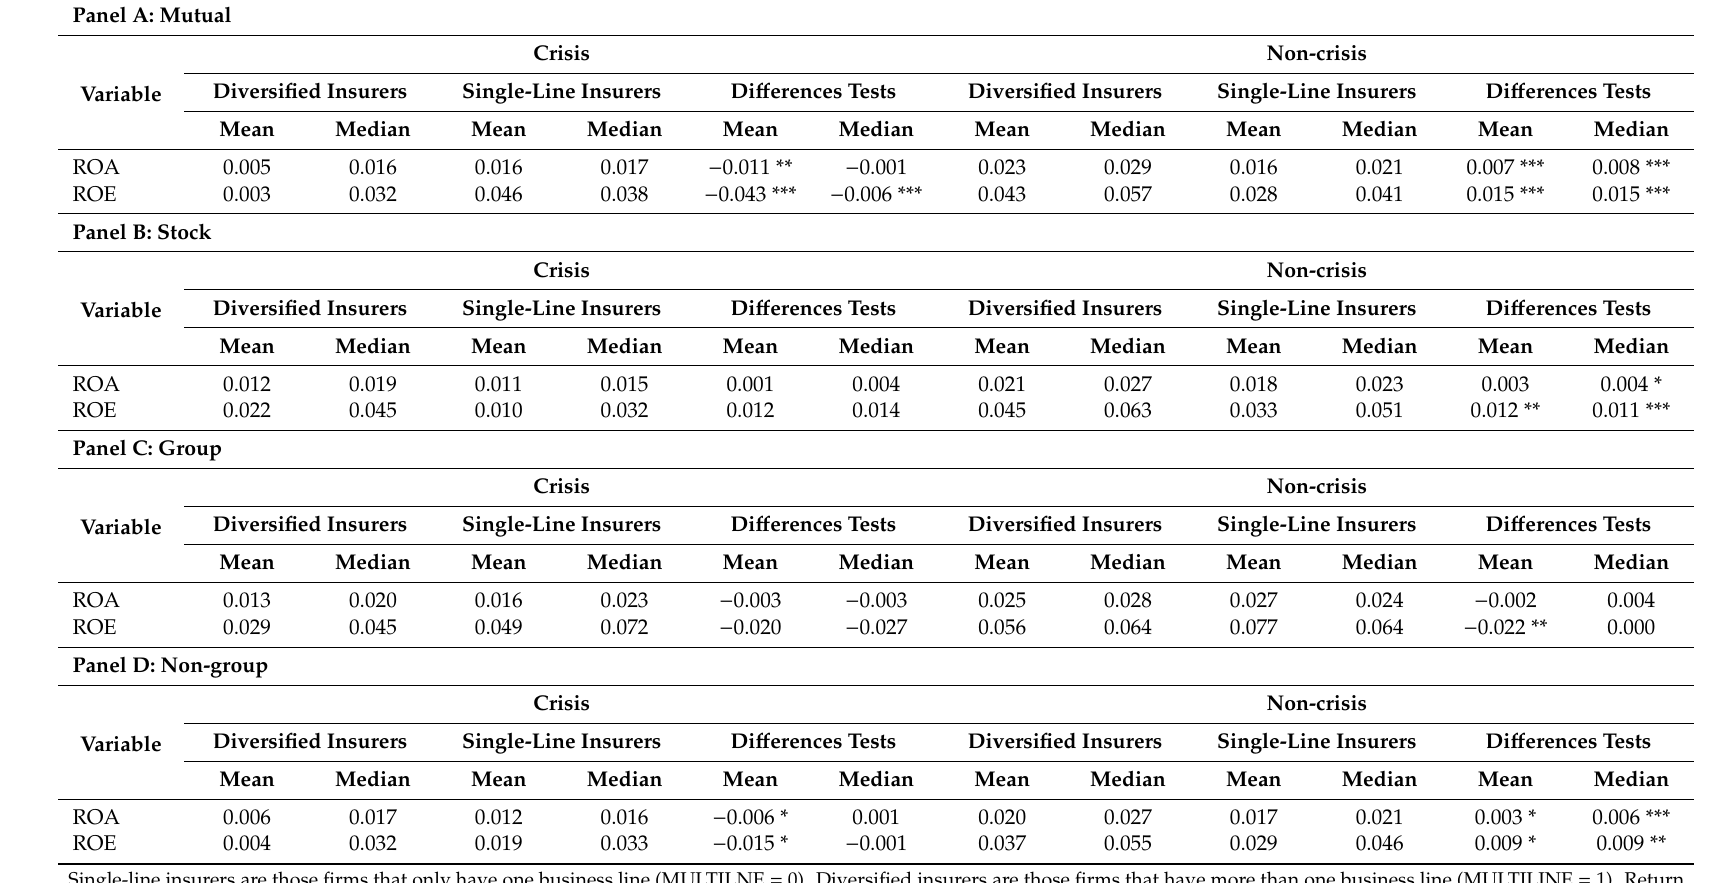
Table 3. Univariate comparison between diversified and single-line insurers during crisis and non-crisis